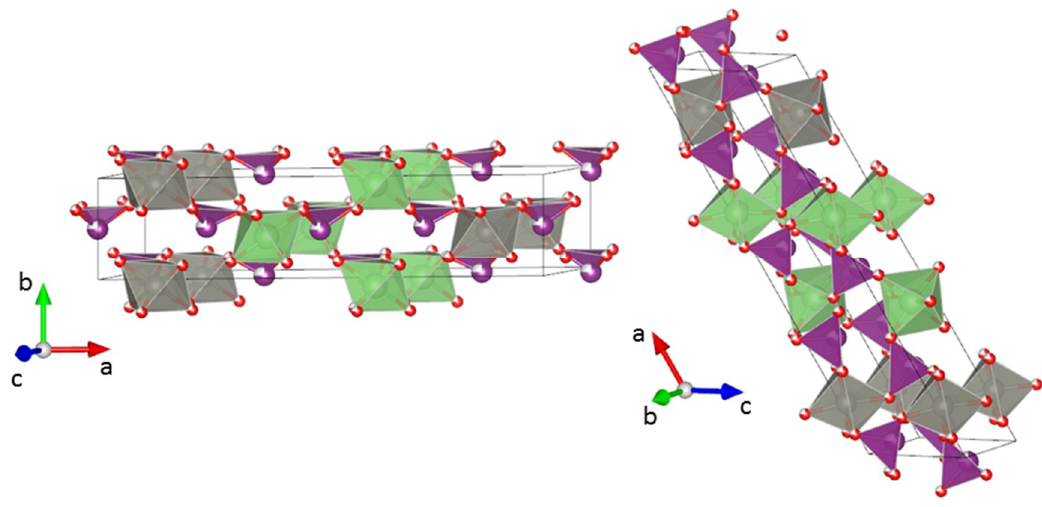
Figure 3. Schematic view of the crystal structure of LiZn(IO 3 ) 3 . Zn (Li) atoms are shown in gray (green), I atoms in violet, and O atoms in red. The site occupation of the last two types of atoms is 0.75. The different coordination polyhedra are shown.